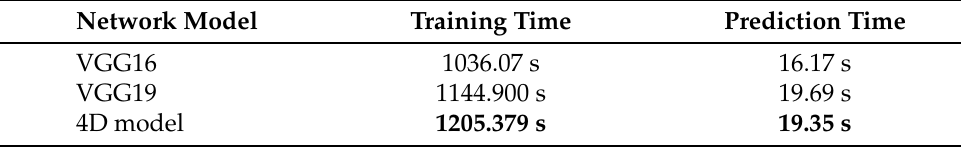
Table 2. Comparison of the training and testing times.